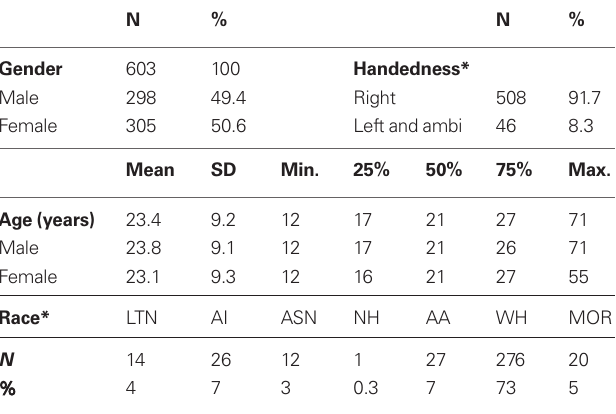
Table 1 | Demographic information. Distributions for primary variables gender and age, as well as secondary variables handedness and